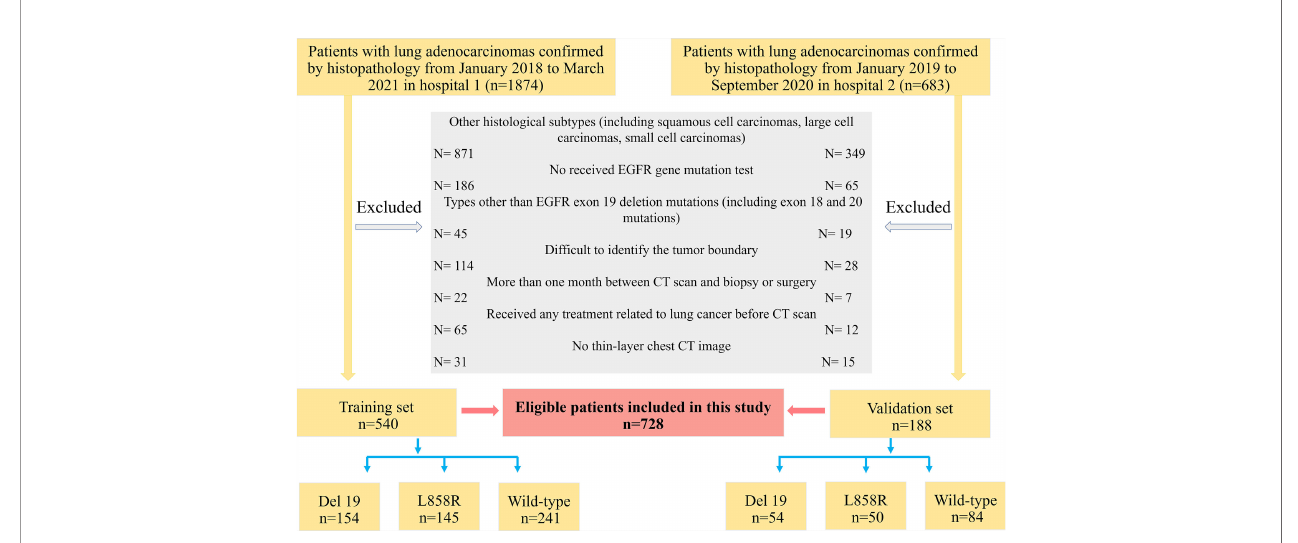
FIGURE 1 | The fl owchart of the inclusion and exclusion